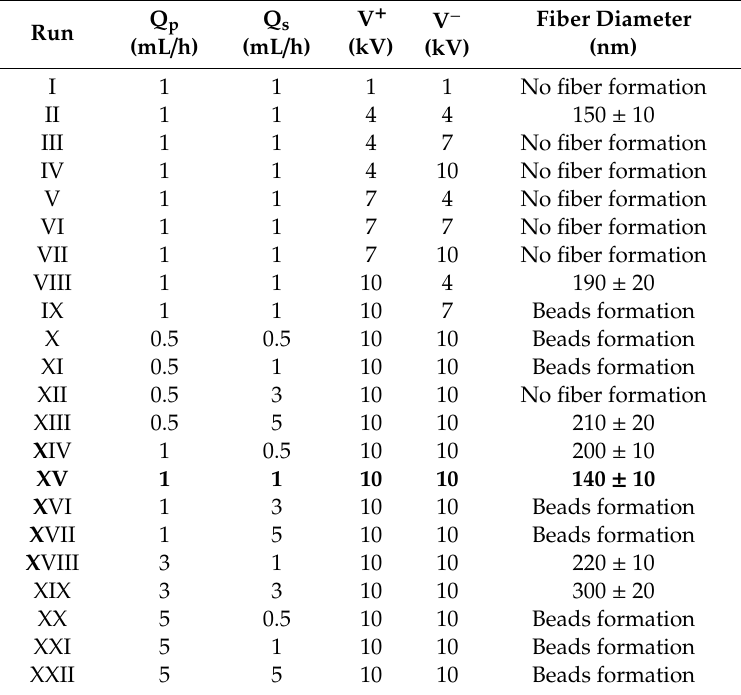
Table 2. Optimization of the electrospinning processing parameters and average fiber diameters for neat